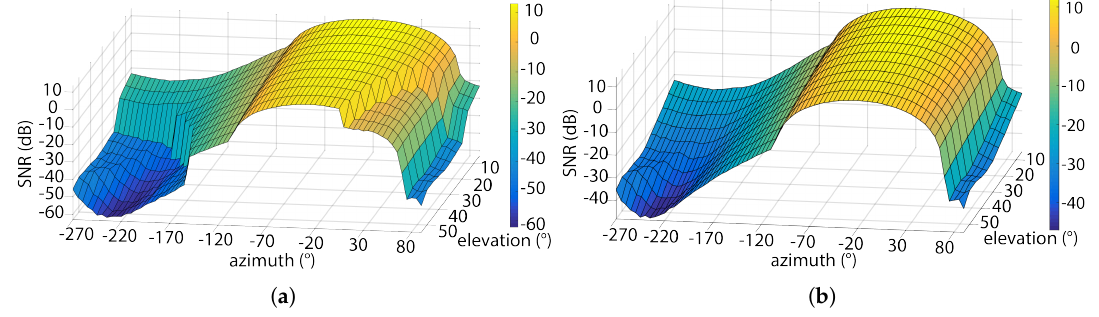
Figure 5. SNR dependency on azimuthal orientation of relay in: ( a ) AF; and ( b )